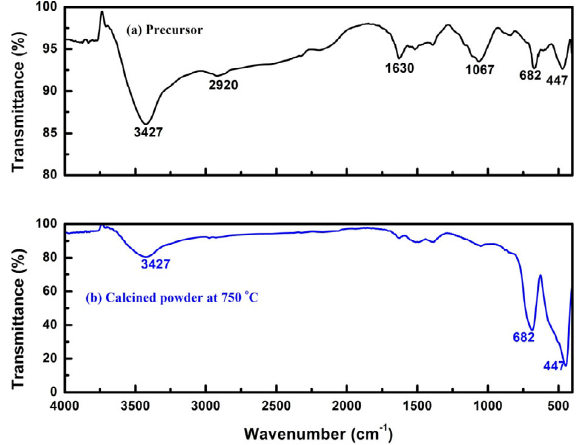
Fig. 4 FT-IR spectra of the dried gel and the powders calcined at 750 ℃ .